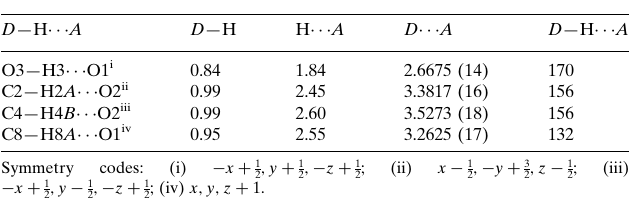
Hydrogen-bond geometry (A˚ , (cid:3)